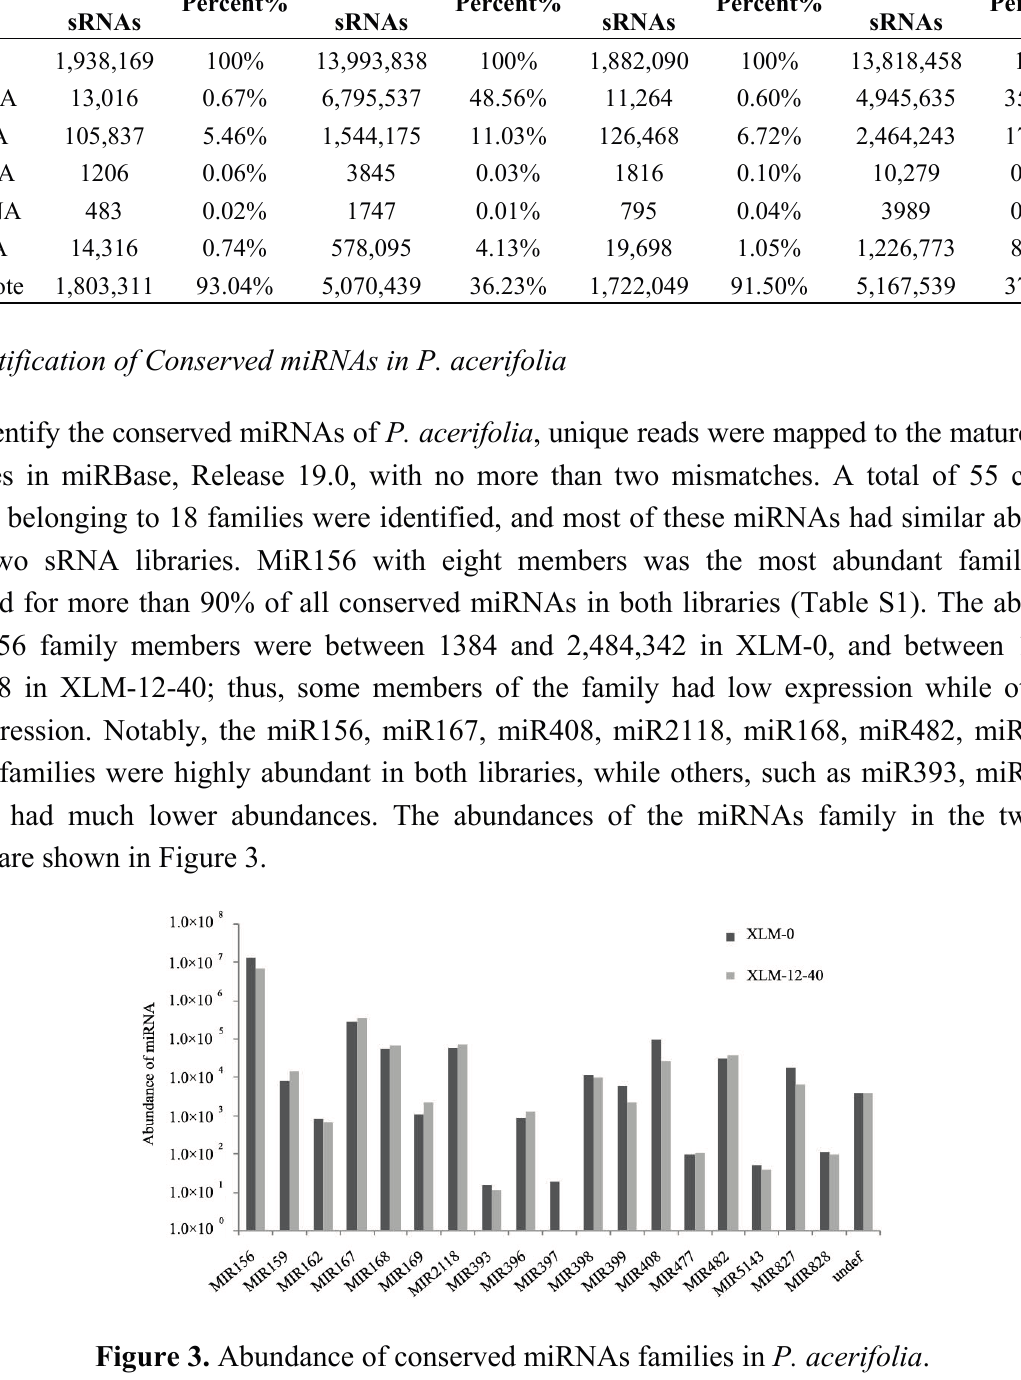
Figure 3. Abundance of conserved miRNAs families in P. acerifolia